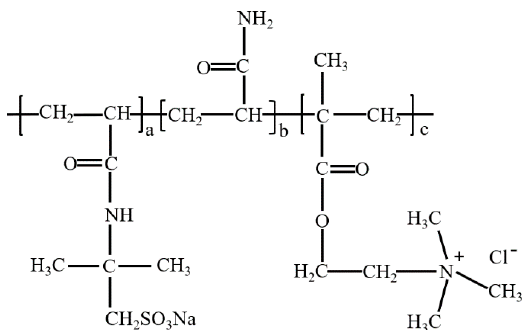
Figure 1. Molecular structure of SDCap (commercial name of P(AM-DMC-AMPS)).